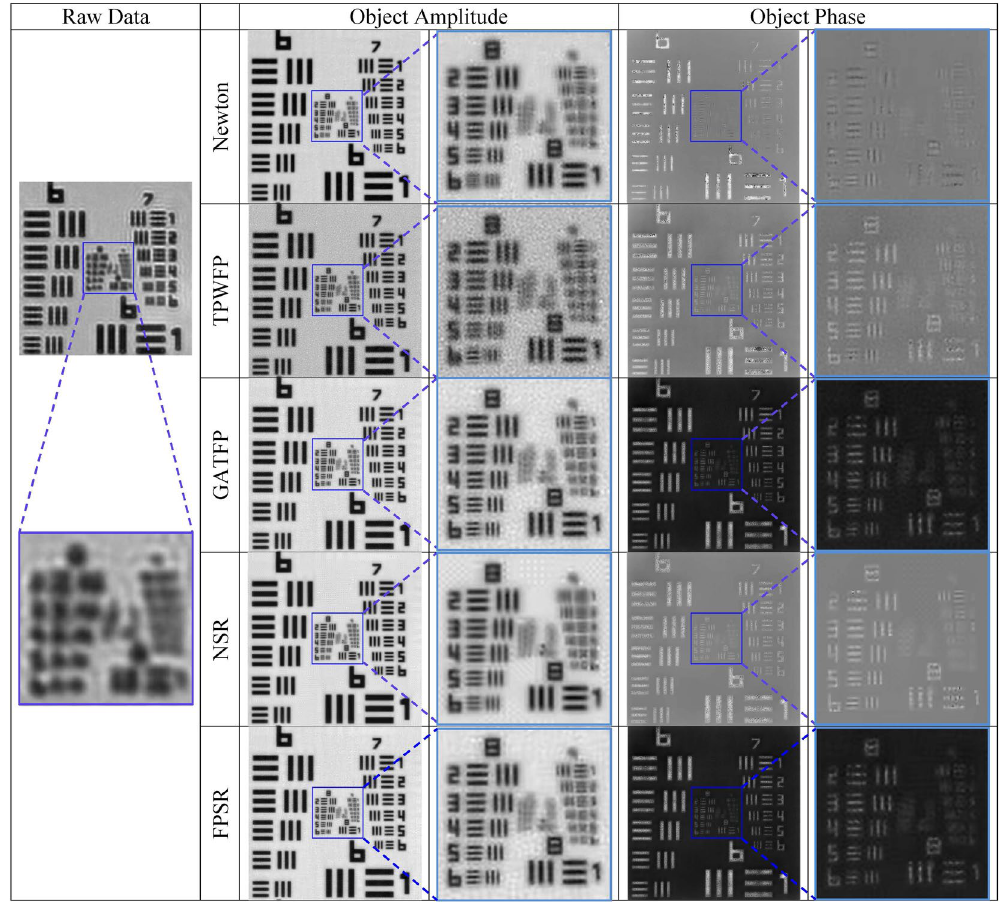
Figure 2. Reconstruction results over USAF target using different algorithms (Newton method, TPWFP, GATFP, NSR and FPSR).